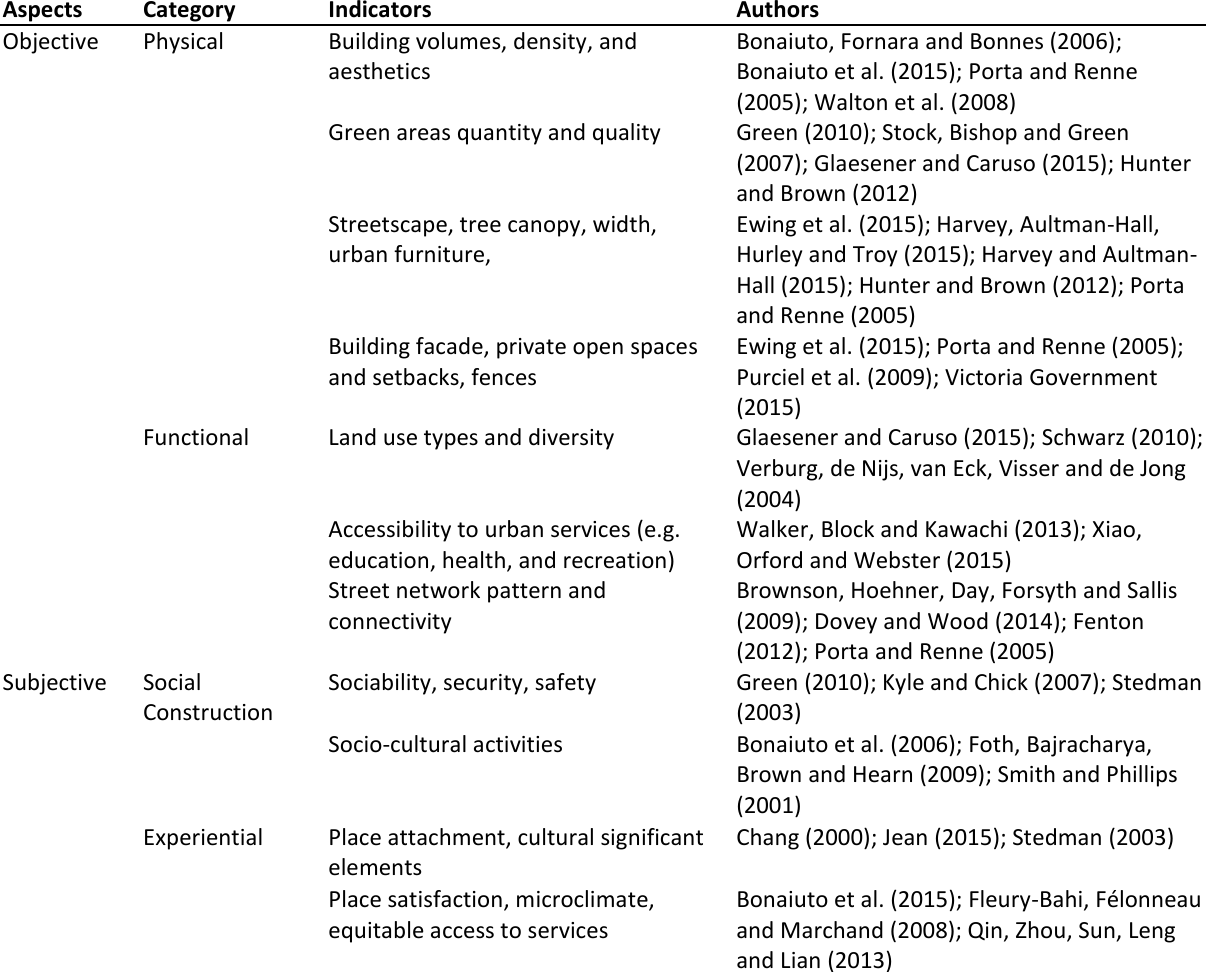
Table 1. Objective and subjective indicators of neighbourhood character as derived from the